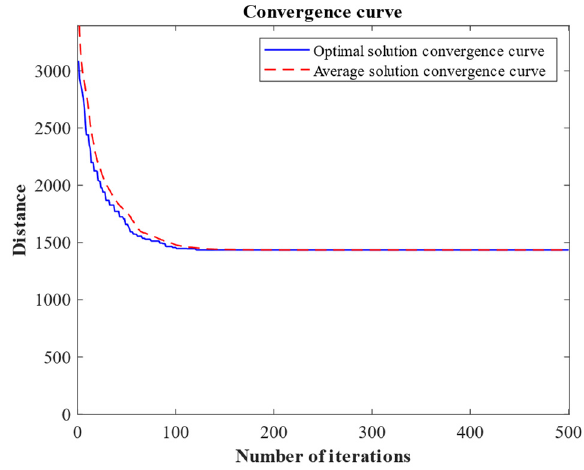
Figure 6. The optimization convergence curve of the cuckoo search algorithm when the number of locations to be visited is 20.